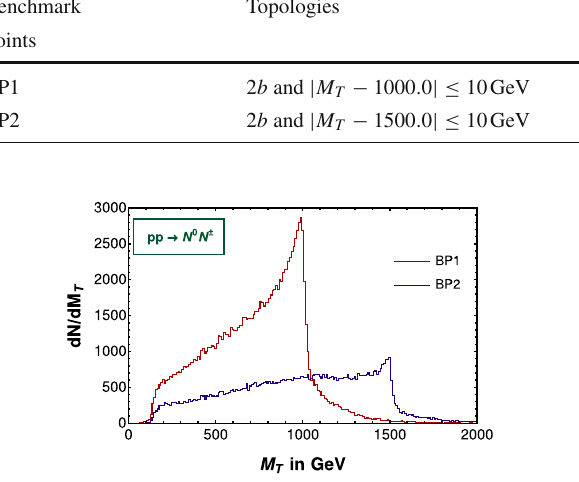
Fig. 16 Thetransverseinvariantmass( M T )distributionfortheprocess p p → N 0 N ± , for the benchmark points at the LHC with Y N = 5 × 10 − 7 and center of mass energy 14 TeV